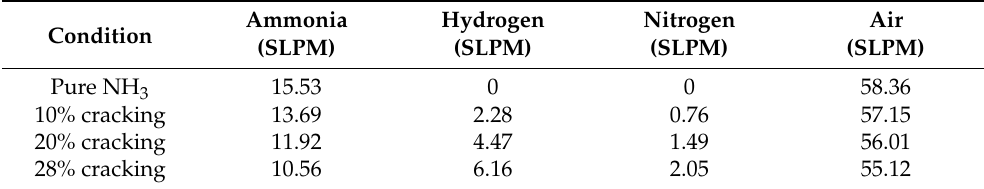
Table 1. Mass flow rates for the four fuel–air blends utilized for the measurements of the flame transfer functions. The equivalence ratio was 0.95, the bulk flow velocity was 7 m/s, and the corresponding thermal power released during adiabatic combustion was about 3.4 kW.